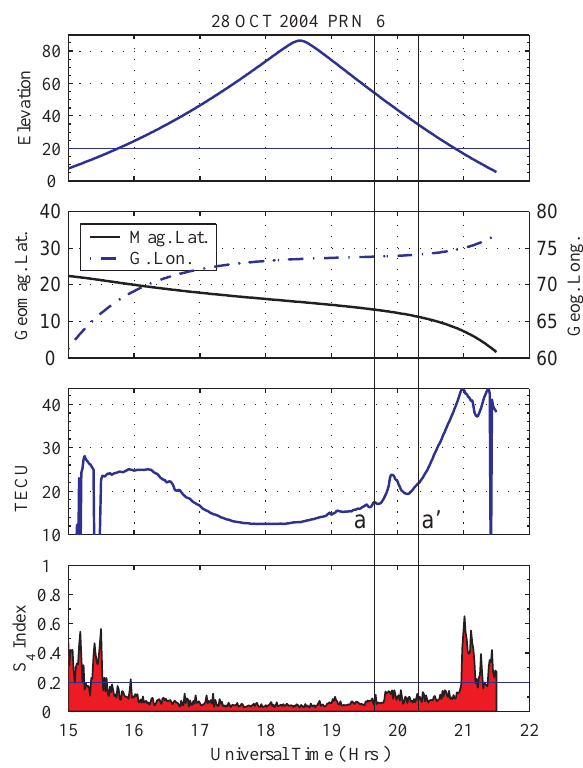
Fig. 5. Observation of a TEC enhancement around 20:00 UT on 28 October 2004 for PRN 6. The S 4 is very low when the TEC enhancement occurs. The rest of the labels are the same as in Fig.